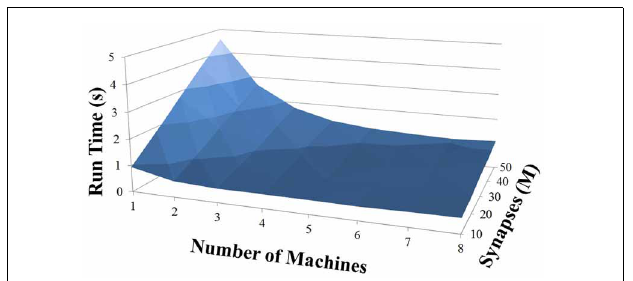
FIGURE 9 | IZH neuron model: bursting firing patterns.